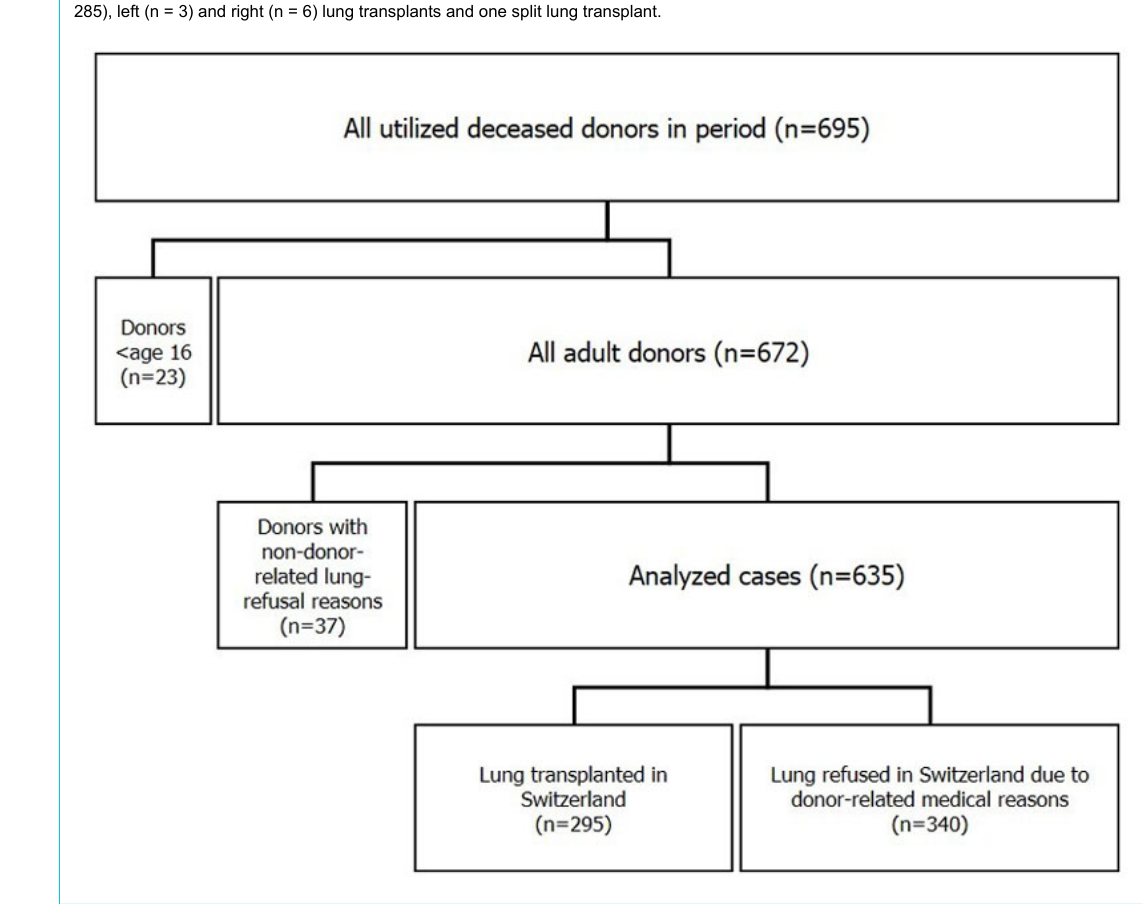
Figure 1: Flowchart of all utilised Swiss deceased donors 2007–2014 . The group “lungs transplanted in Switzerland” included double (n = 285), left (n = 3) and right (n = 6) lung transplants and one split lung